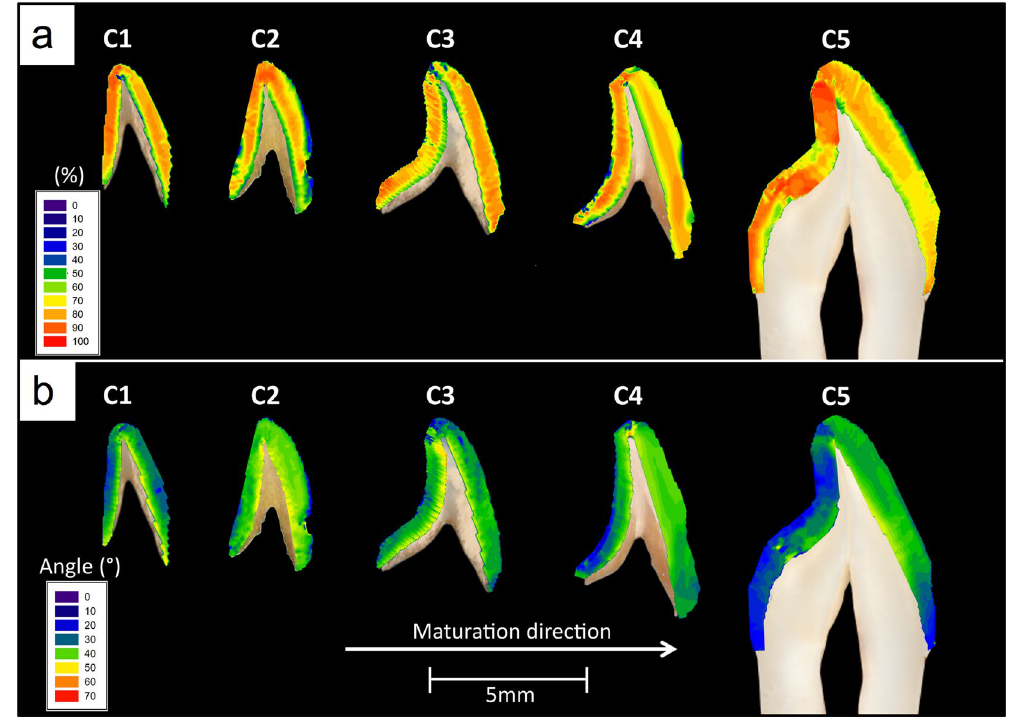
section the labial surface is on the right hand